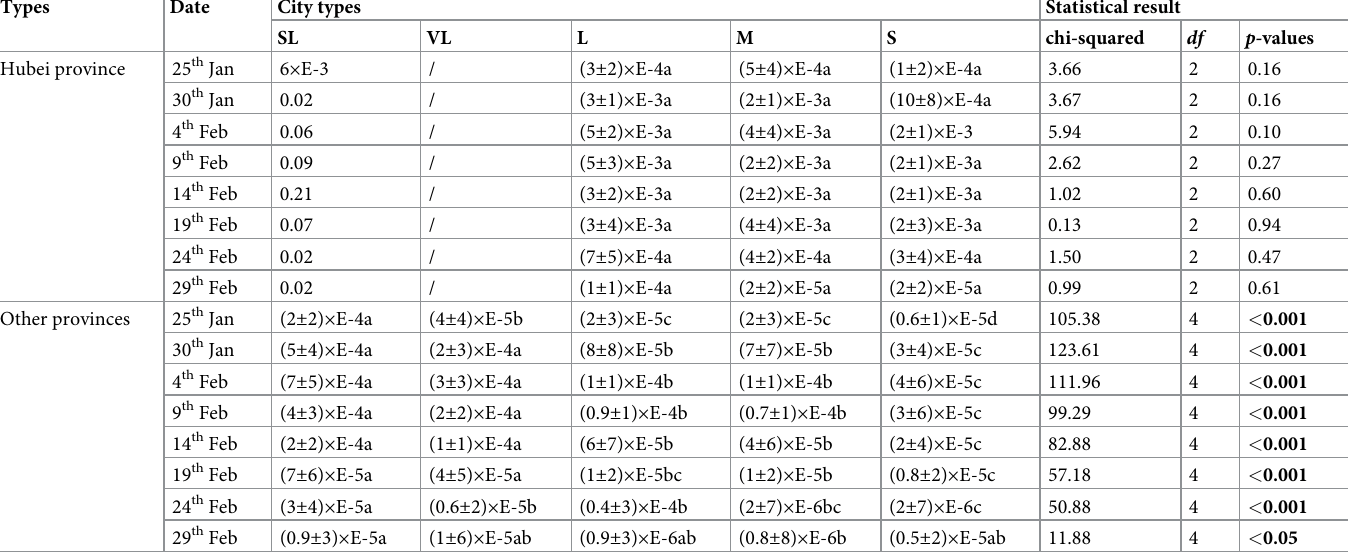
Table 2. Differences in the confirmed cases over population size per 100000 at every 5 consecutive days (CCOPSPTT) among five types of cities outside and within Hubei province from 25th January to 29th February,